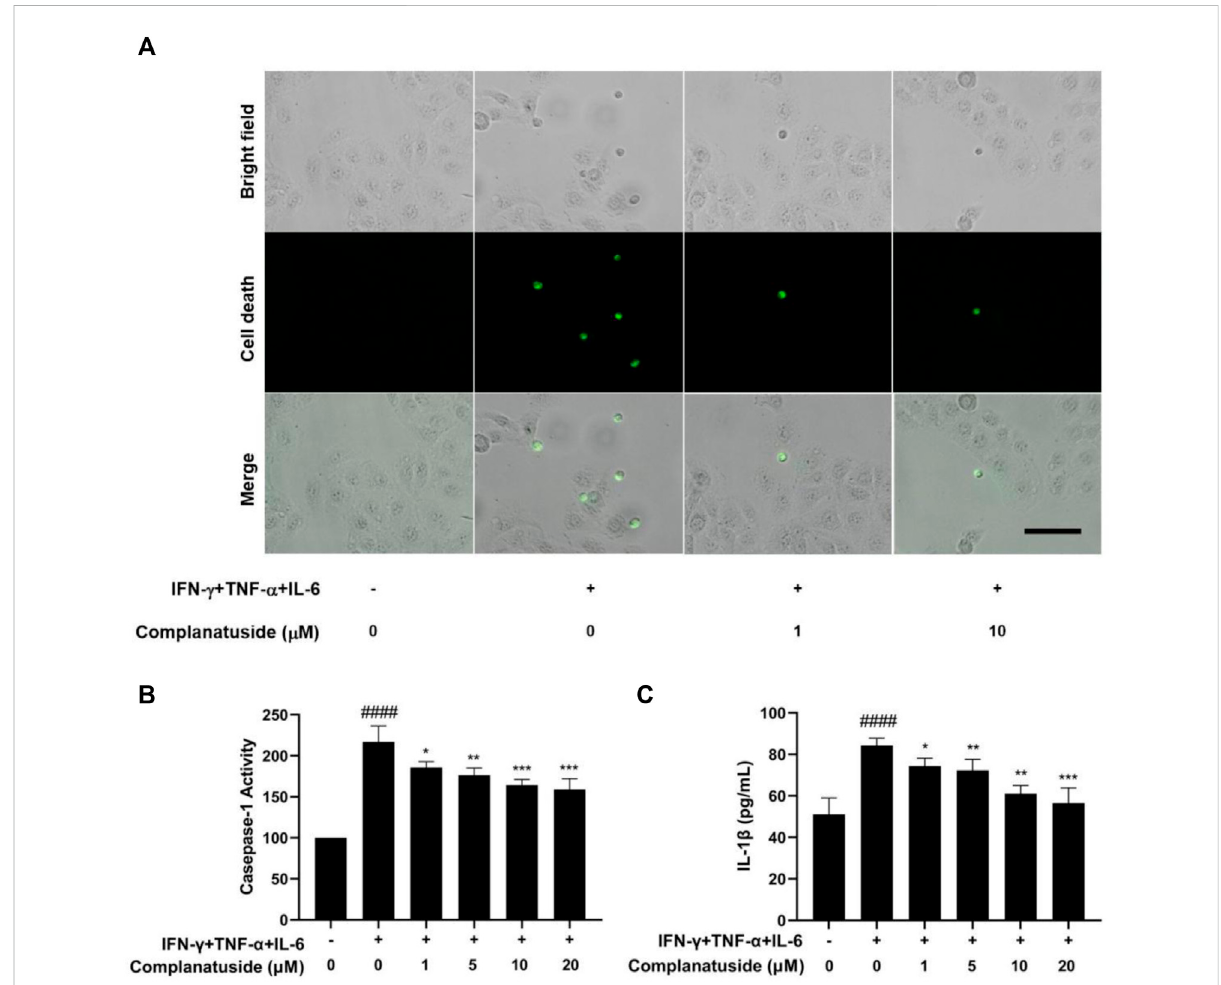
FIGURE 5 ProtectiveeffectofcomplanatusideonpyroptosisinHaCaTcellsinducedbythecytokinecombination. (A) Representativemicrographsofcaspase- 1staininginHaCaTcellstreatedwithcomplanatusideinthepresenceorabsenceofthecytokinecombination(Sizebar=25 µm). (B) Caspase-1activityin HaCaTcellswasmeasuredusingthecaspase-1assaykit. (C) ELISAwasusedtomeasurethelevelsofIL-1 β .Thedatawerepresentedasmean±SD( n =3), #### = p < 0.0001ascomparedwithcontrolgroup, * = p < 0.05, ** = p < 0.01,and *** = p < 0.001ascomparedwiththecellstreatedwithcytokine